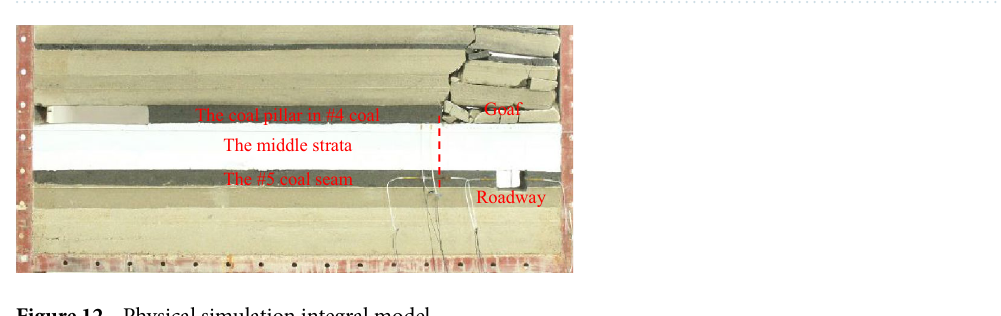
Figure 12. Physical simulation integral